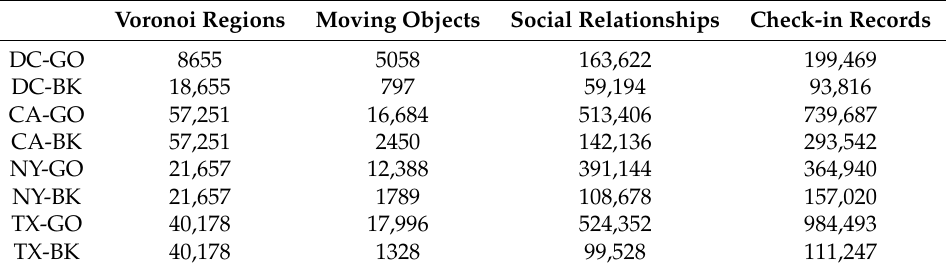
Figure 7. Spatial distribution of check-in records. Table 2. Experimental